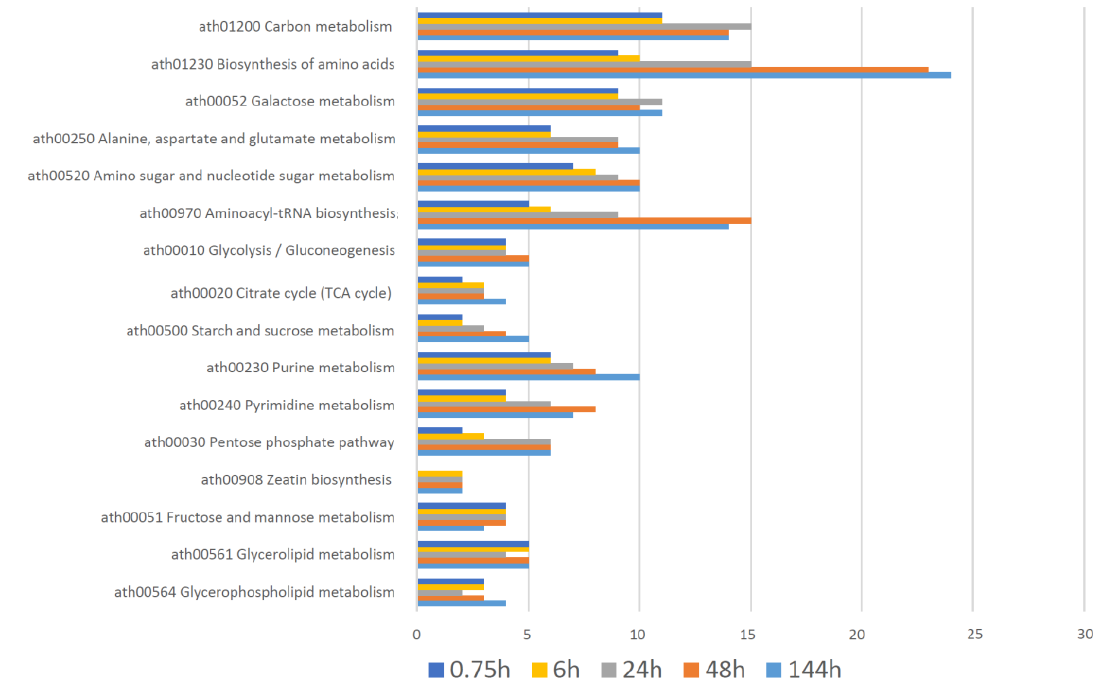
Figure 3. Changes in the number of di ff erential metabolites in di ff erent pathways during seed germination. The abscissa represents the number of metabolites.